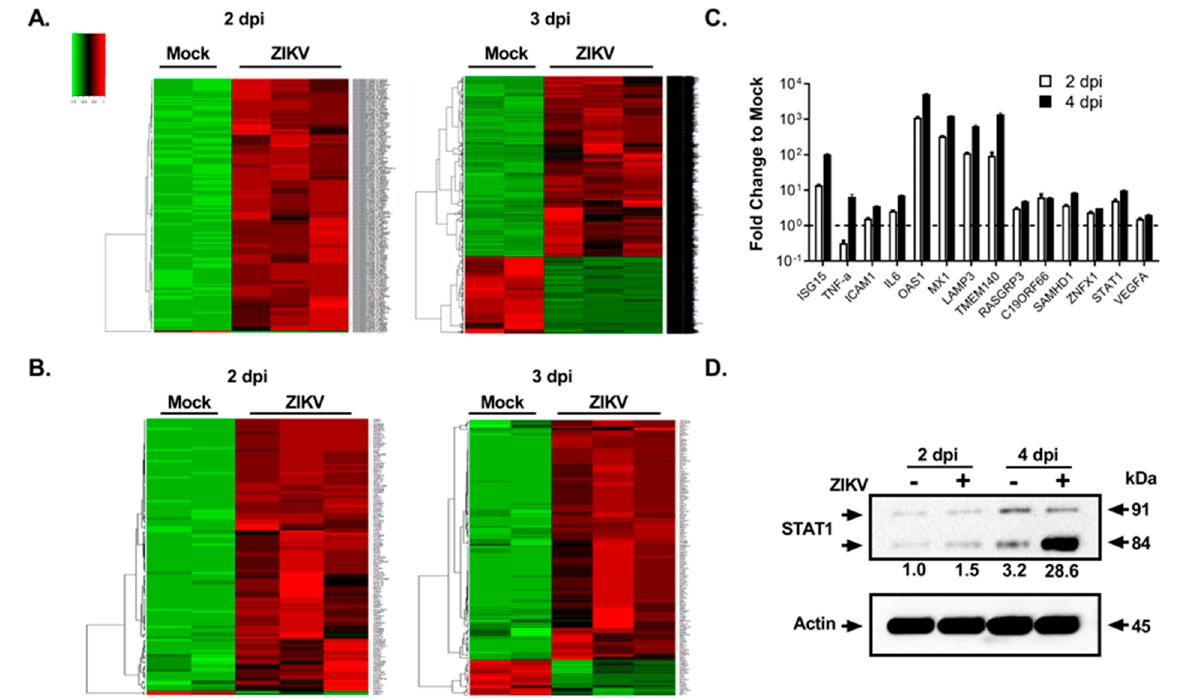
Figure 2. ZIKV dysregulates host cellular processes and activates innate immune and inflammatory responses in fetal RPE cells. ( A ) Heat map of differentially expressed genes at 2 dpi (2040 genes) and 3 dpi (7951 genes) [upregulated (red); downregulated (red)]. 2-way supervised Hierarchical Clustering was performed using unique genes identified for the combined dataset. ( B ) Heat maps show the differential expression of known canonical ISGs in mock and ZIKV infected cells at 2 dpi (128 genes) and 3 dpi (184 genes). ( C ) RT-qPCR validation of selected inflammatory and IFN-stimulated genes from ( B ) in ZIKV infected FRPE cells at 2 and 4 dpi. The fold change to mock is shown. The dash line represents the mock value at 1 where the fold change was taken for the specified time points. ( D ) Western blot showing the induction of STAT1 after ZIKV infection at 2 and 4 dpi. Note that higher levels of STAT1 beta subunit (84 kDa) are present in infected cells. Actin was included as a loading control. Actin normalized density of bands compared to that of 2 dpi mock is provided for 84 kDa beta STAT1 isoform. ZIKV infections were done in biological triplicates for each time point. The uninfected controls were done in biological quadruplicates and pooled in duplicate for downstream